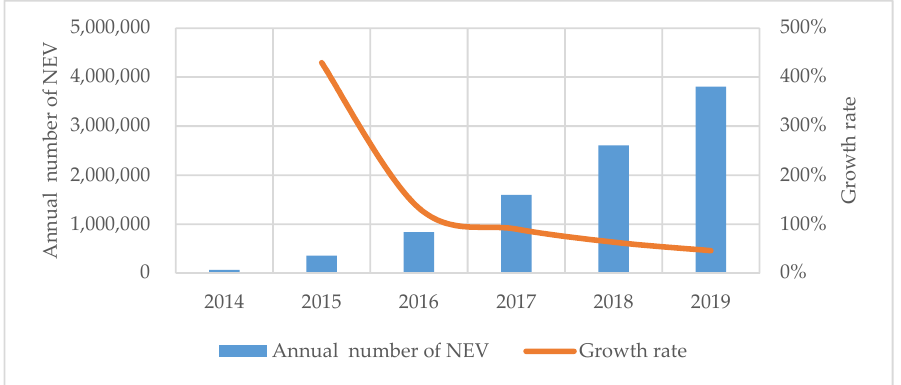
Figure 1. Industrial progress of new energy vehicles (NEVs) in China.